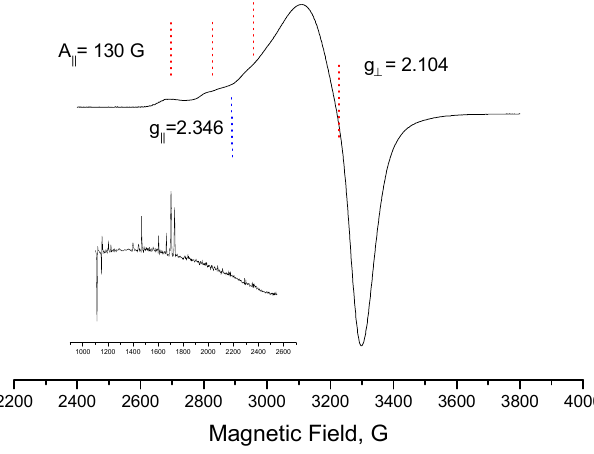
Figure 5. EPR spectra for the [CuCl 2 (INH) 2 ]·H 2 O complex ( 1 ) registered in a frozen DMSO solution at 77 K.